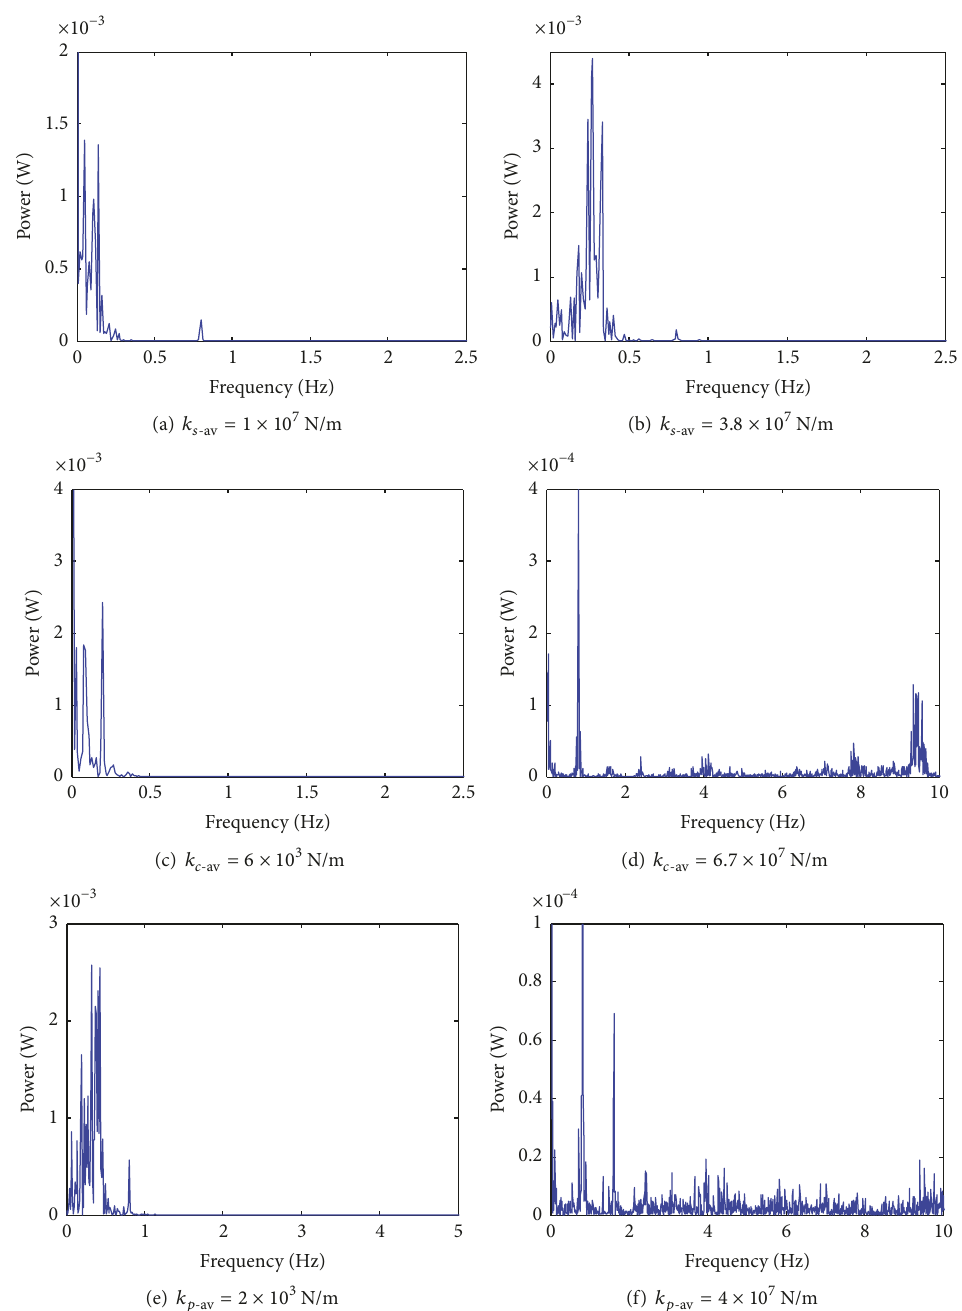
Figure 7: Power spectrum of torsional vibration response for different average mesh